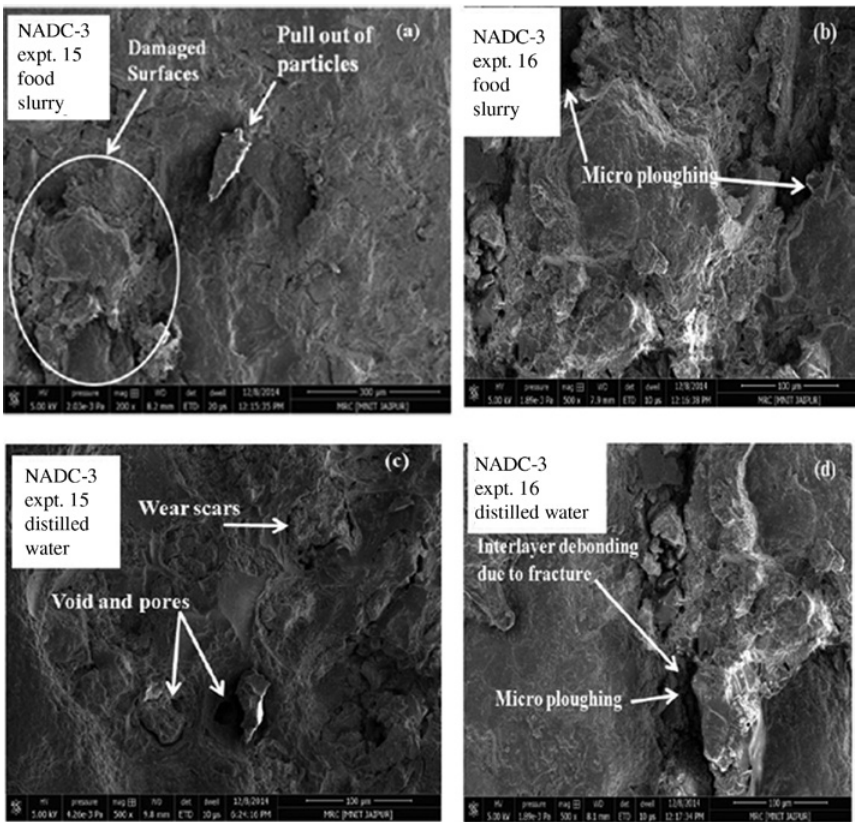
Figure 13: FE-SEM images of worn surfaces of composite filled with 2 wt.% nanoalumina under Taguchi experimental design: (a) Expt. 15, food slurry; (b) Expt. 16, food slurry; (c) Expt. 15, distilled water; and (d) Expt. 16, distilled